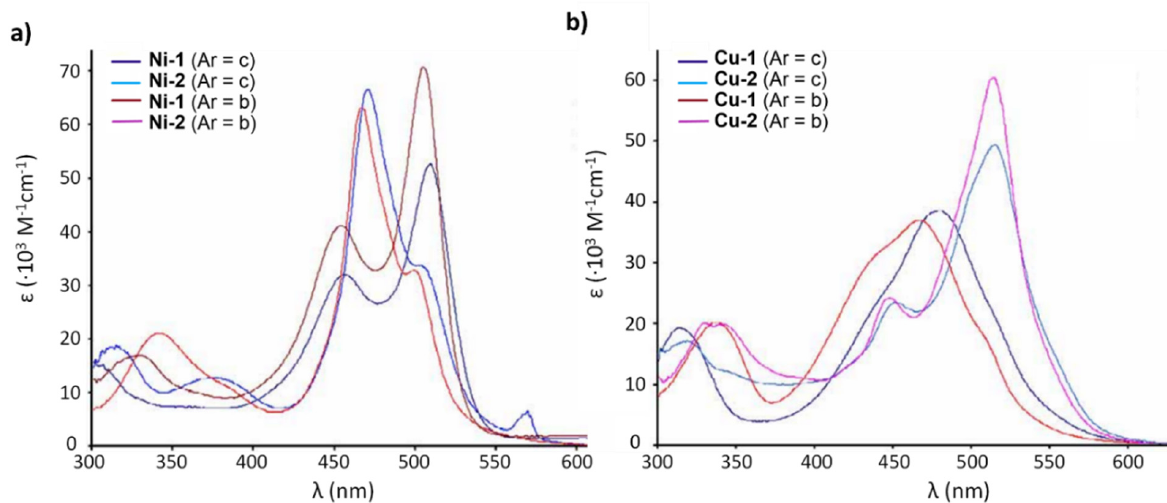
Figure 24. UV-Vis absorption spectra of several ( a ) bis(dipyrrinato)Ni(II) and ( b ) -Cu(II) complexes in DCM. Reproduced with permission from [184]. Copyright © 2009 Royal Society of Chemistry.